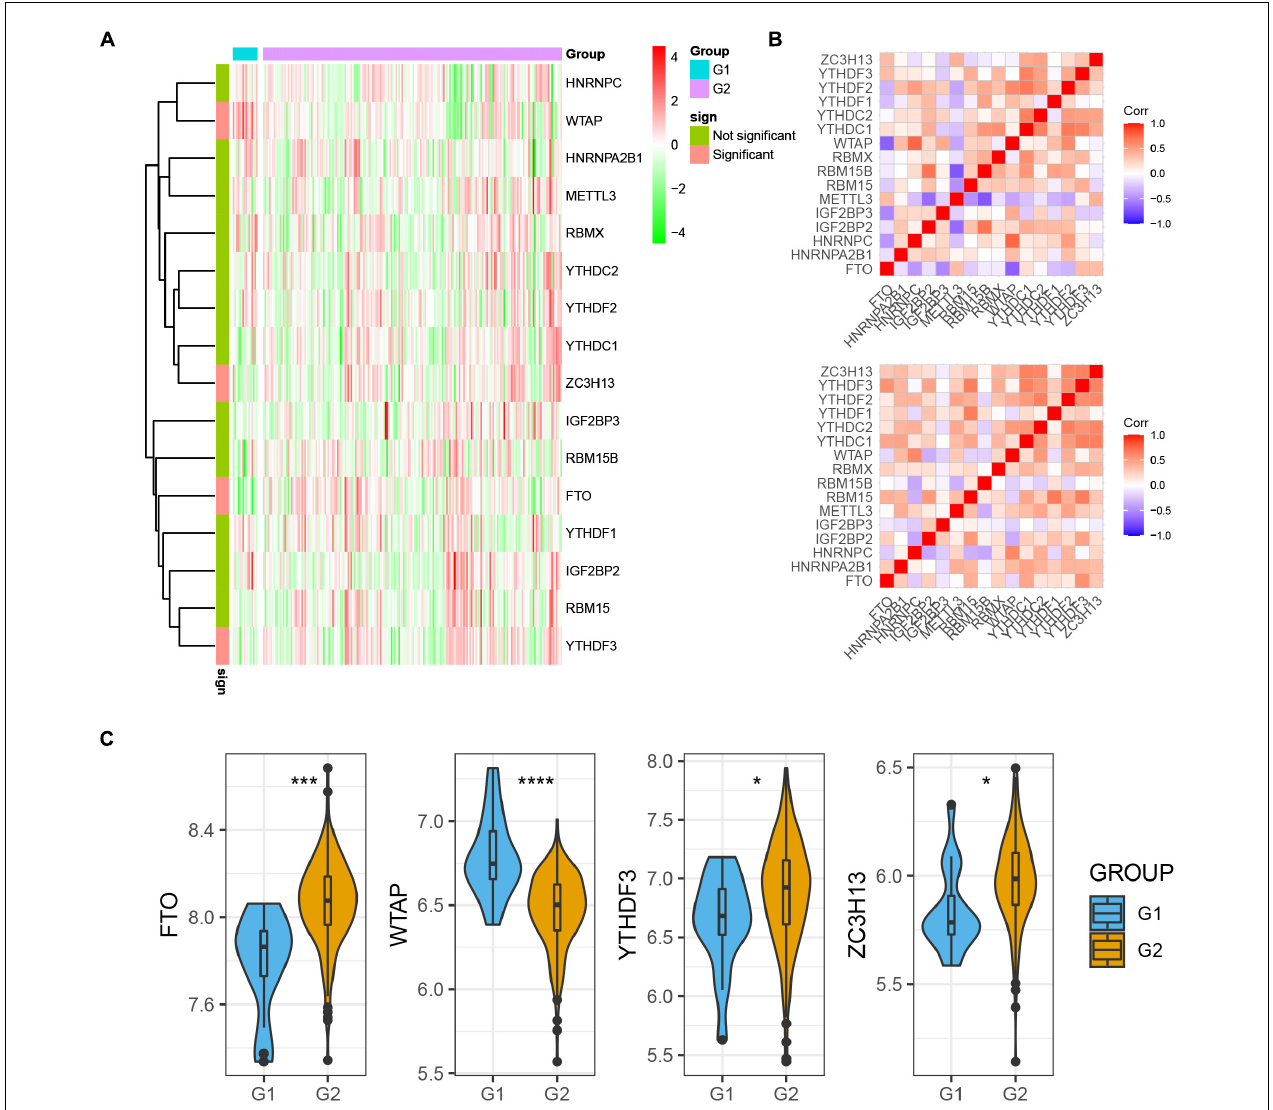
FIGURE 1 | m6A regulators expression was dysregulated in MI. (A) m6A modulators were differently expressed in MI. (B) Correlation among m6A regulators’ expression in MI samples and non-failing samples. (C) Dysregulation of FTO, YTHDF3, ZC3H13, and WTAP in MI was presented. * P < 0.05; *** P < 0.001; **** P <